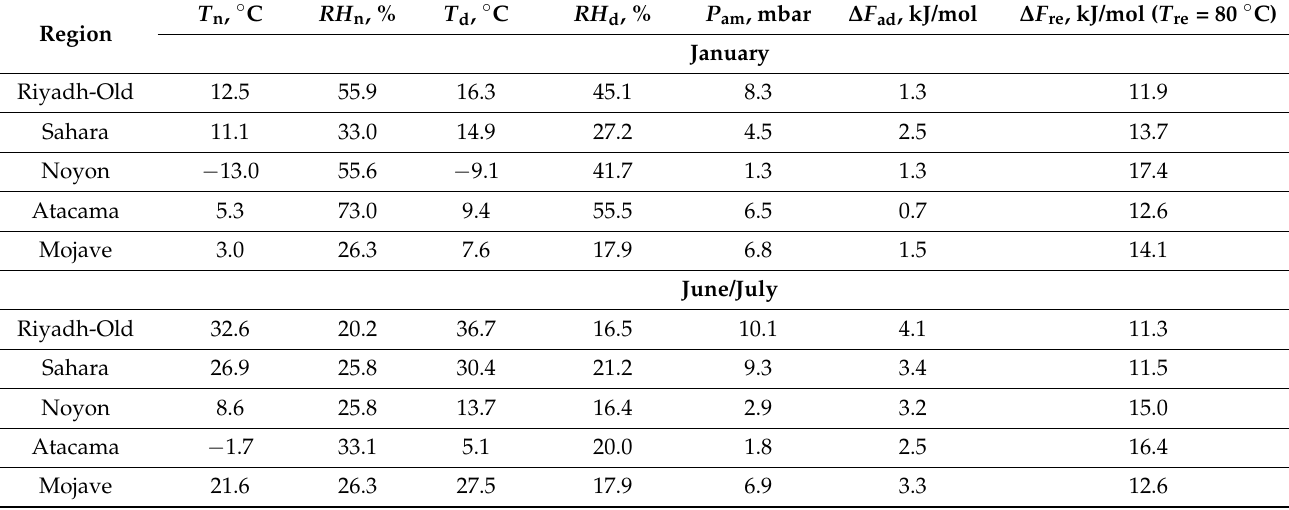
Table 1. Climatic data for the selected regions.